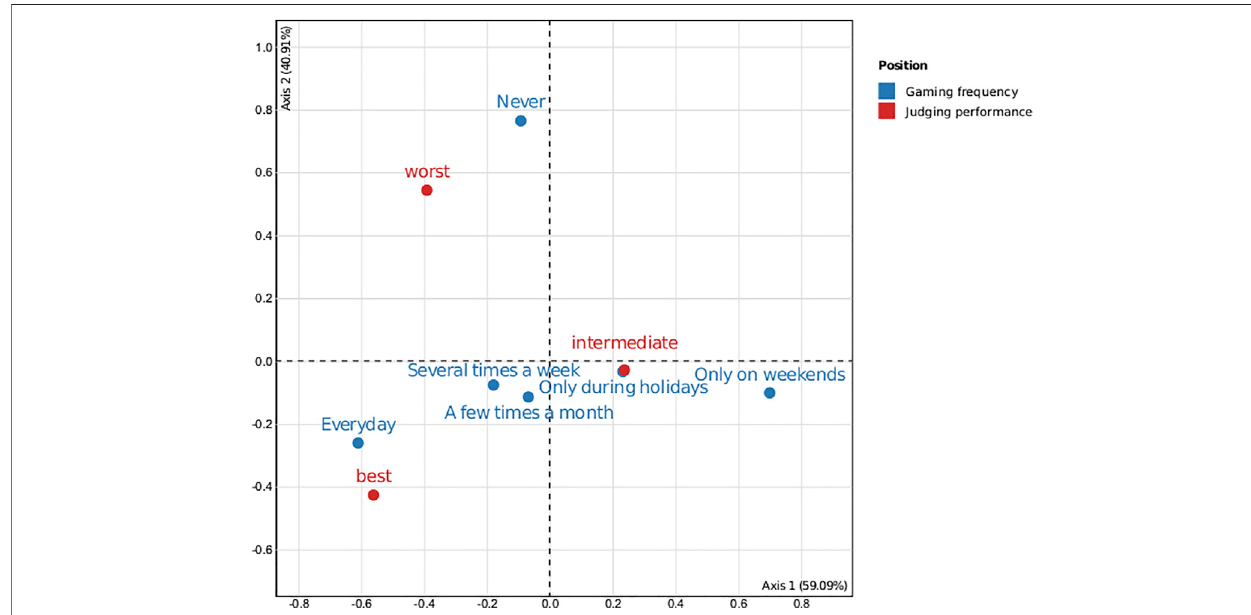
FIGURE 6 | Correspondence analysis factor map.